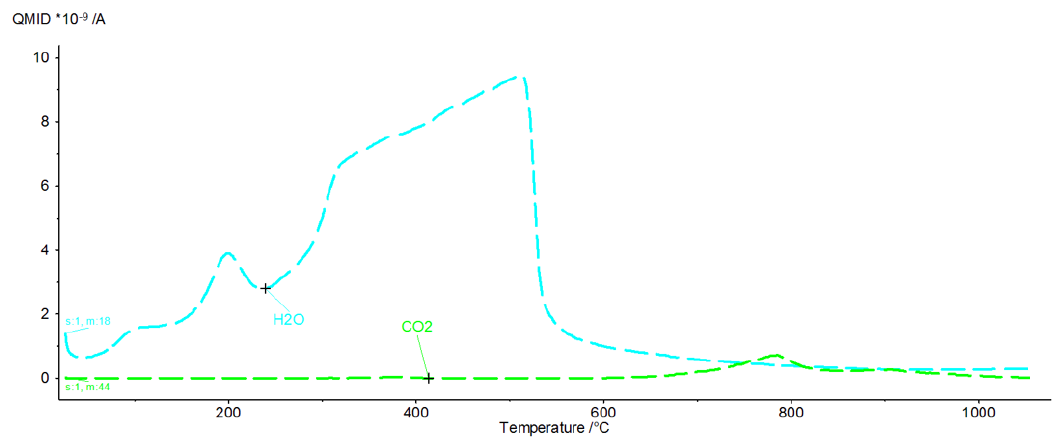
Figure 12. H 2 O and CO 2 release curves from sample G as ionic current as a function of temperature.